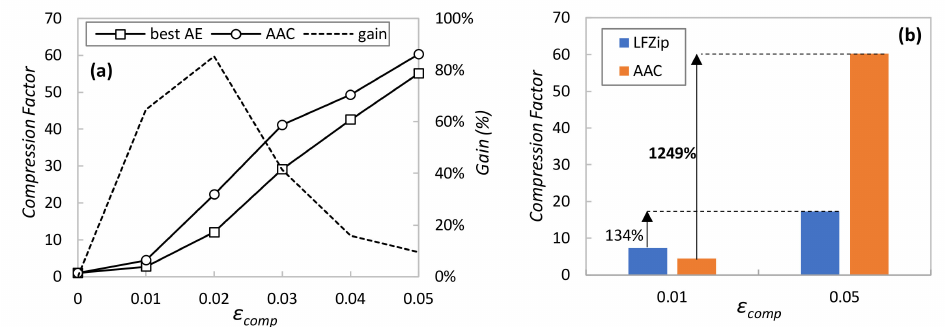
Figure 6. AAC benchmarking against the best single AE ( a ) and LFZIP ( b )